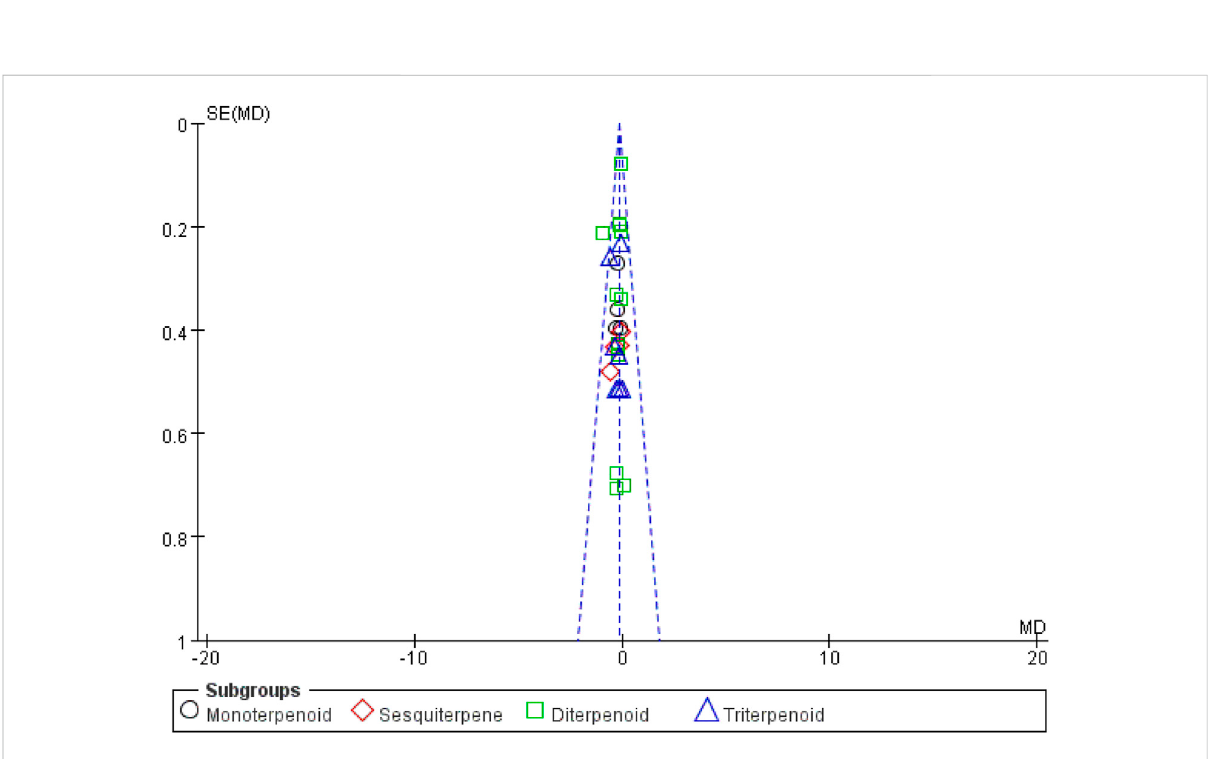
FIGURE 3 The funnel plot for accessing publication